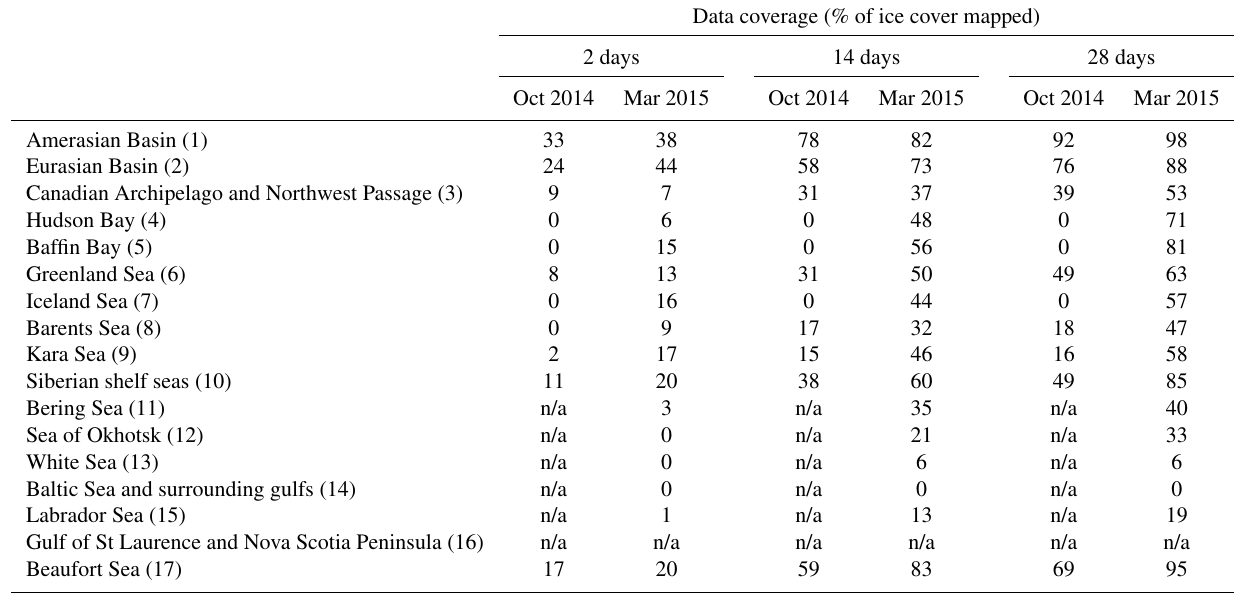
Table 1. Variations in the sampling of CryoSat-2 near-real-time (NRT) sea-ice-thickness products in 17 Arctic Ocean basins. Regions 1–10 encompass all October sea ice, and regions 1–16 encompass all March sea ice. Region 17 is a subregion of region 1 (Fig.